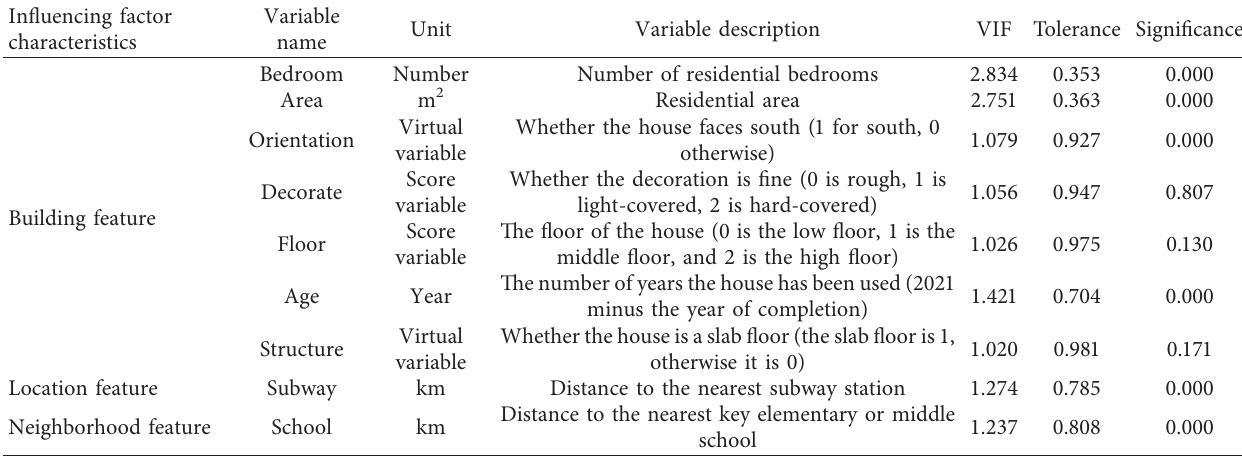
Table 1: Variable